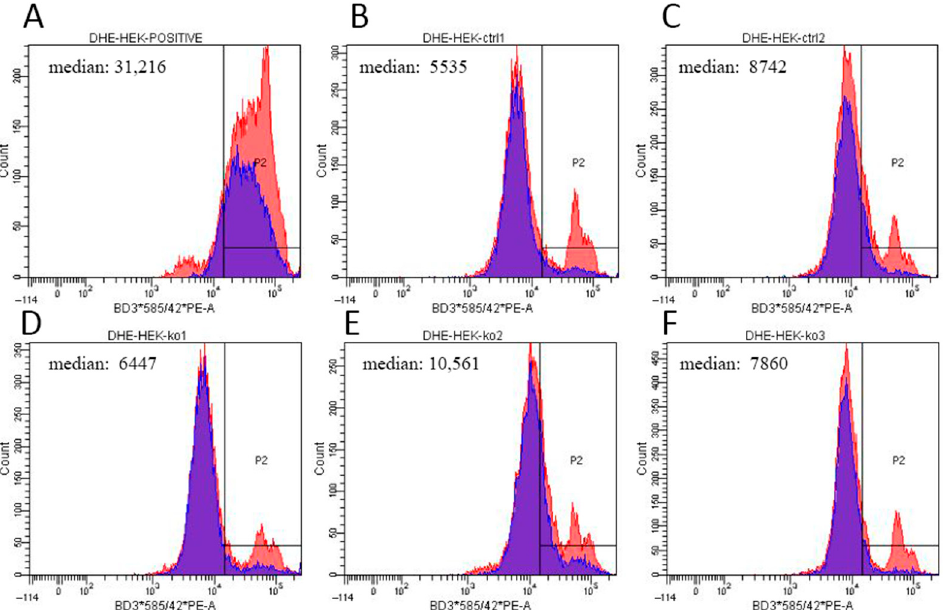
Figure A3. Quantification of Western blots from Figure 4. ( A ) BN-PAGE/WB of HEK293 ACBD3-KO, ( B ) BN-PAGE/WB of HeLa ACBD3-KO, ( C ) SDS-PAGE/WB of HEK293 ACBD3-KO, and ( D ) SDS-PAGE/WB of HeLa ACBD3-KO. ‘n’ represents number of independent analyses per sample.